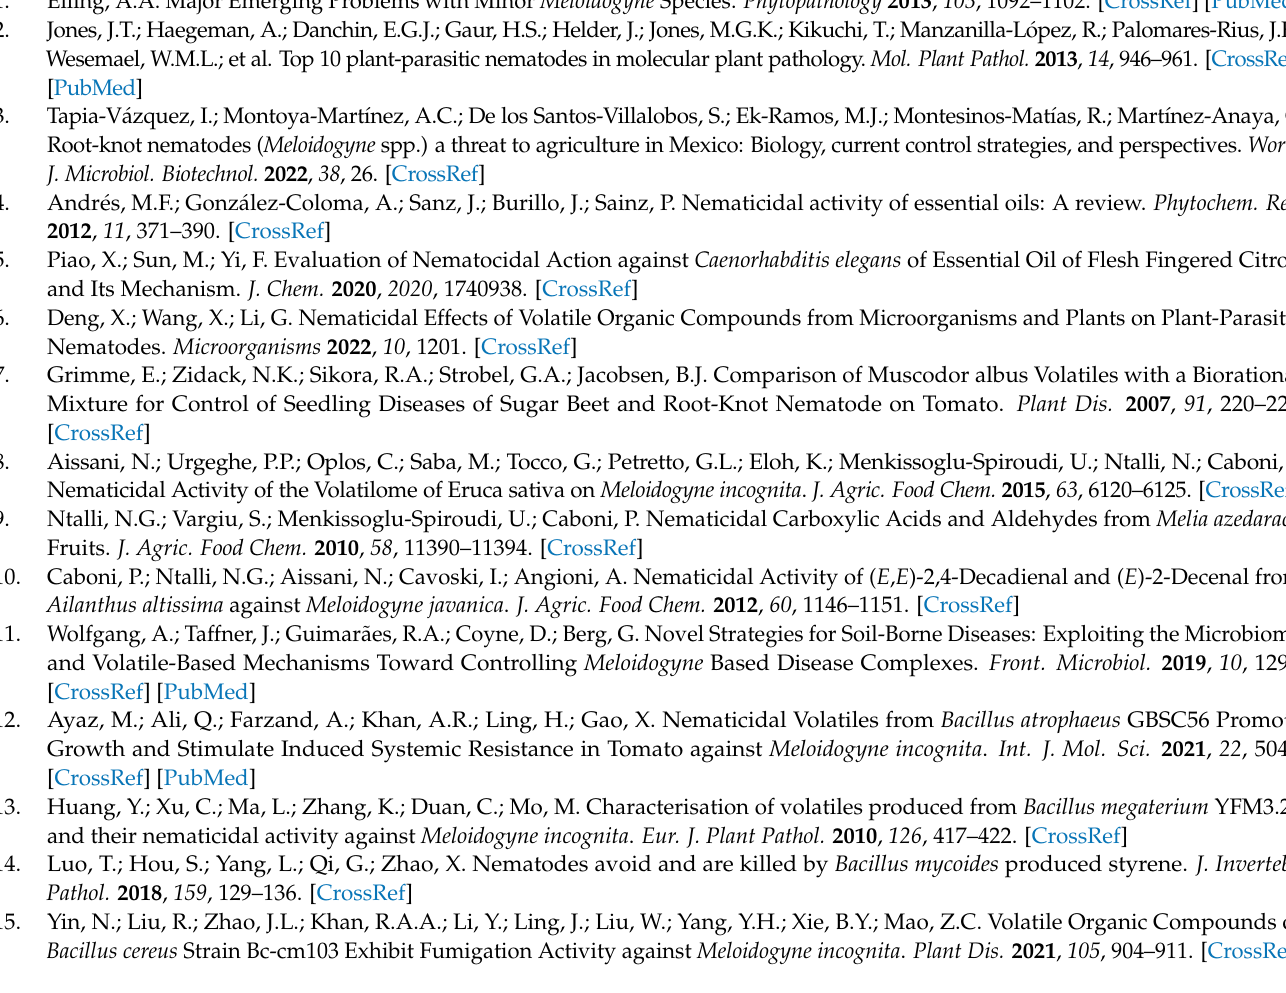
information; Table S1: Forty-two volatile organic compounds identified from B. diminuta via GC-MS; Table S2: Commercial information of 10 VOCs used to test nematicidal activity; Table S3: Thirty-eight butyl-butyrate-like volatile esters and commercial information; Figure S1: The GC-MS chromatogram of NB medium; Figure S2: The GC-MS chromatogram of B. diminuta . Author Contributions: Conceptualization, G.L.; methodology, Y.S., Y.R., H.Y., M.M. and G.L.;